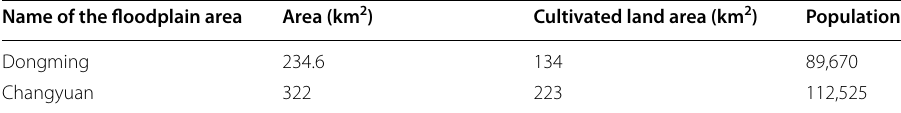
Table 3 Economic situation of Dongming and Changyuan floodplain area Name of the floodplain area